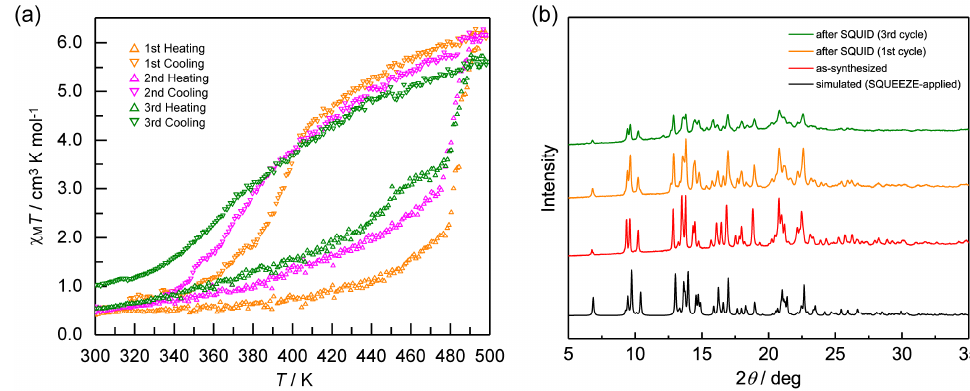
Figure 6. ( a ) Temperature dependence of the χ M T product of 1·AsF 6 in the heating (empty triangles) and cooling (empty inverted triangles) modes over three successive thermal cycles at a sweep rate of 0.5 K·min − 1 . Orange: first cycle; magenta: second cycle; olive: third cycle; ( b ) Powder X-ray diffraction (PXRD) patterns of 1·AsF 6 at RT in different states. Black: simulated from the SQUEEZE-applied single crystal X-ray data at 120 K; red: as-synthesized 1·AsF 6 ; orange: 1·AsF 6 after the first thermal cycle of superconducting quantum interference device (SQUID) measurement; olive: 1·AsF 6 after a third thermal cycle of SQUID measurement.